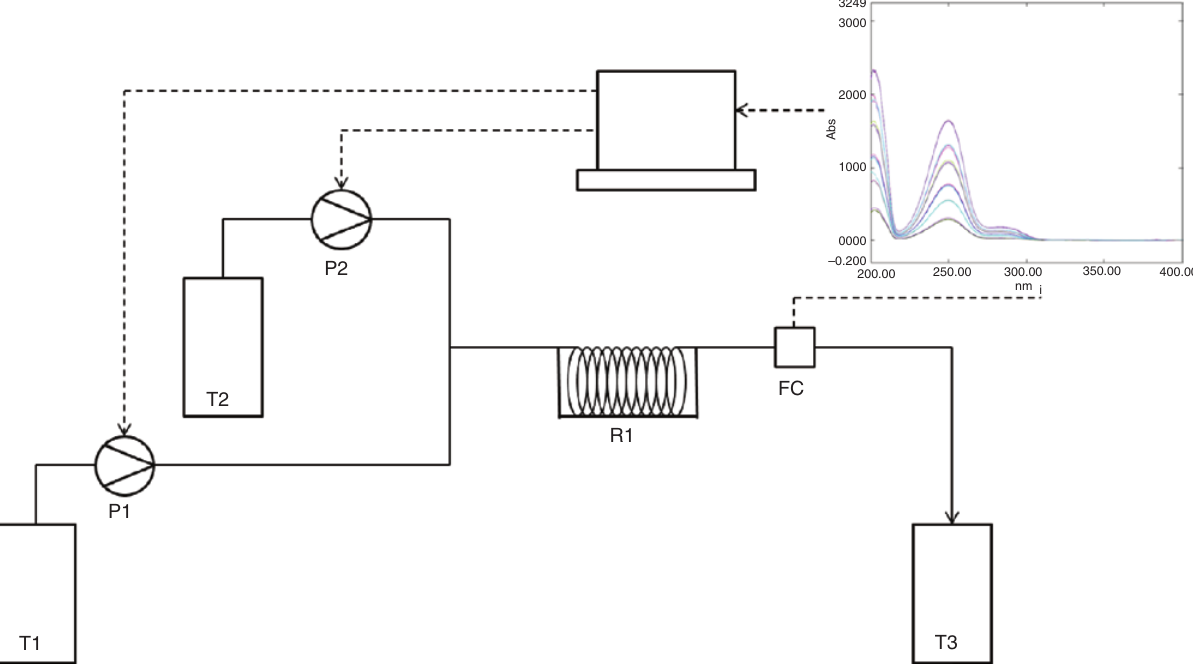
Figure 7: Experimental setup for performing the chemical reaction between tris(hydroxymethyl)aminomethane (TRIS) and benzaldehyde in a tubular laminar reactor with in-line ultraviolet-visible (UV-VIS) real time process monitoring. Process flow sheet including: T1, T2, T3 – tanks; P1 and P2 – pumps; T – thermometer, FC – flow cell and R1 – tubular laminar reactor.